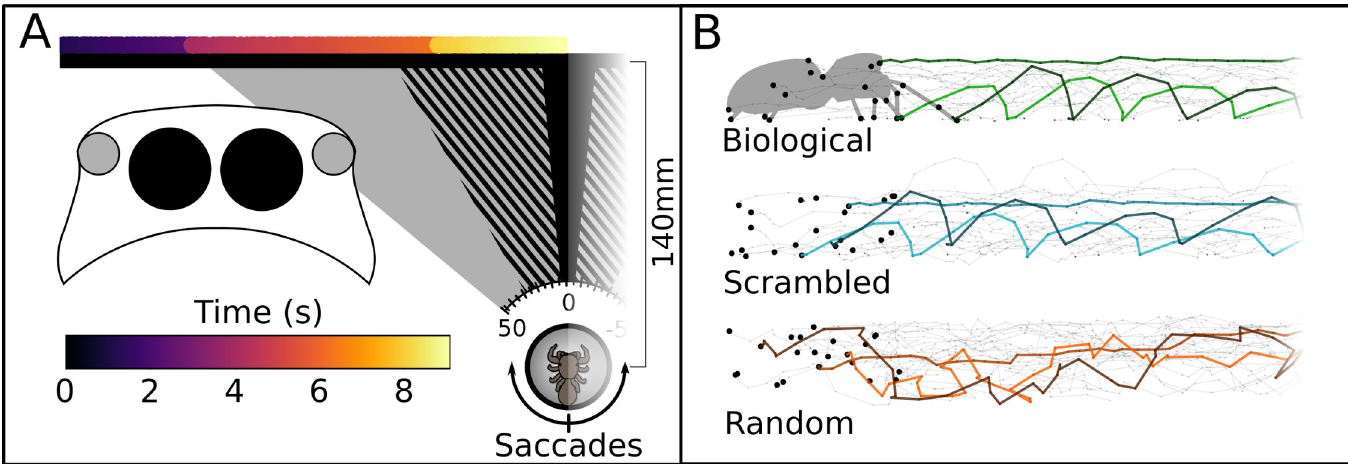
Fig 1. Stimuli movement across the screen and of each point. (A) Schematic representation of the setup, left half. The black horizontal line represents the computer screen. The colored line above represents the position of the stimulus across time (color scale). Note the sudden color changes where the stimulus paused for 1.5 seconds before starting to move again. Once at the center, the stimulus disappeared behind a white box. To turn toward any stimulus on the screen, the spider can produce saccades, by pivoting around its vertical axis (z-axis of the sphere). Cones drawn toward the screen: visual field of the different eyes. In black, the visual field of the AME. The striped area represents the extended visual field of the AME when moved. In gray, the visual field of the ALE. Note that the visual field of the remaining eyes covers all the rest of the screen. Large overlay schematic on left depicts a jumping spider cephalothorax, seen frontally with the AME in black, and the ALE in gray. (B) Point-light displays. On the left, the full set of dots for the first frame. For the biological, the silhouette has been superimposed on the dots, to show how they correlate with the spider’s joints. For each stimulus, the paths for 3 points (the same 3 in all displays) is highlighted. Note how for the scrambled display, while the position of the points is different from the biological, the path that they follow is identical. A AU : AbbreviationlistshavebeencompiledforthoseusedthroughoutFigs 1 and 2 : Pleaseverifythatallentriesarecorrect : LE, anterior lateral eyes; AME, anterior medial eyes.